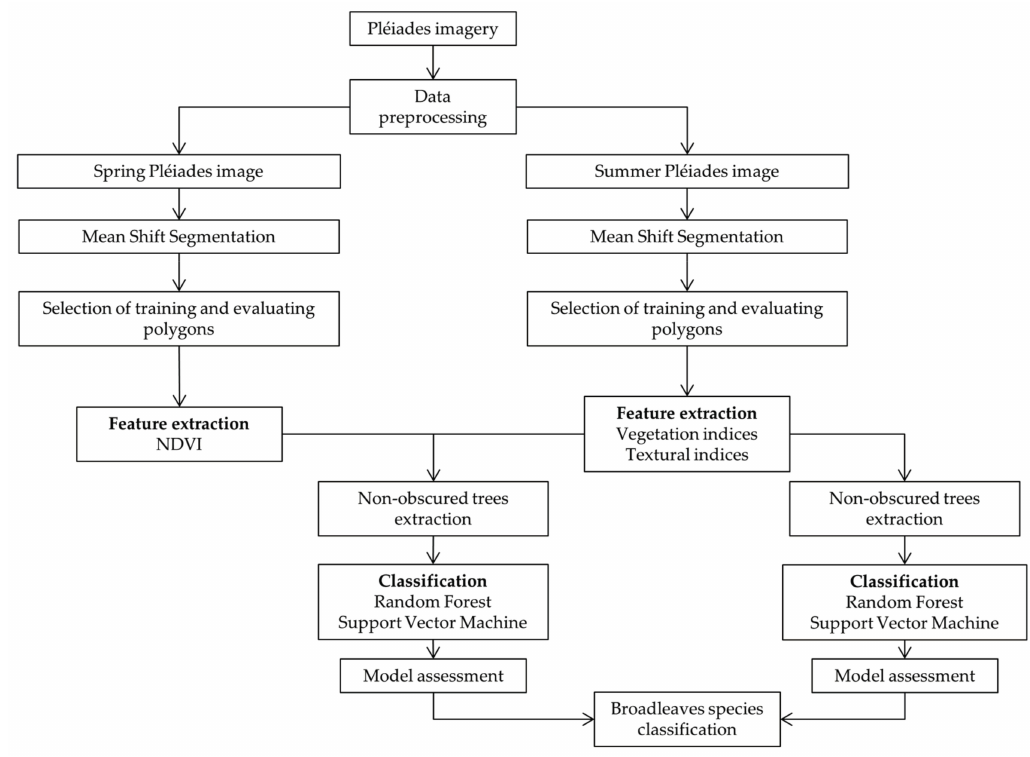
Figure 4. Workflow of the urban tree species classification procedure using the Pl é iades